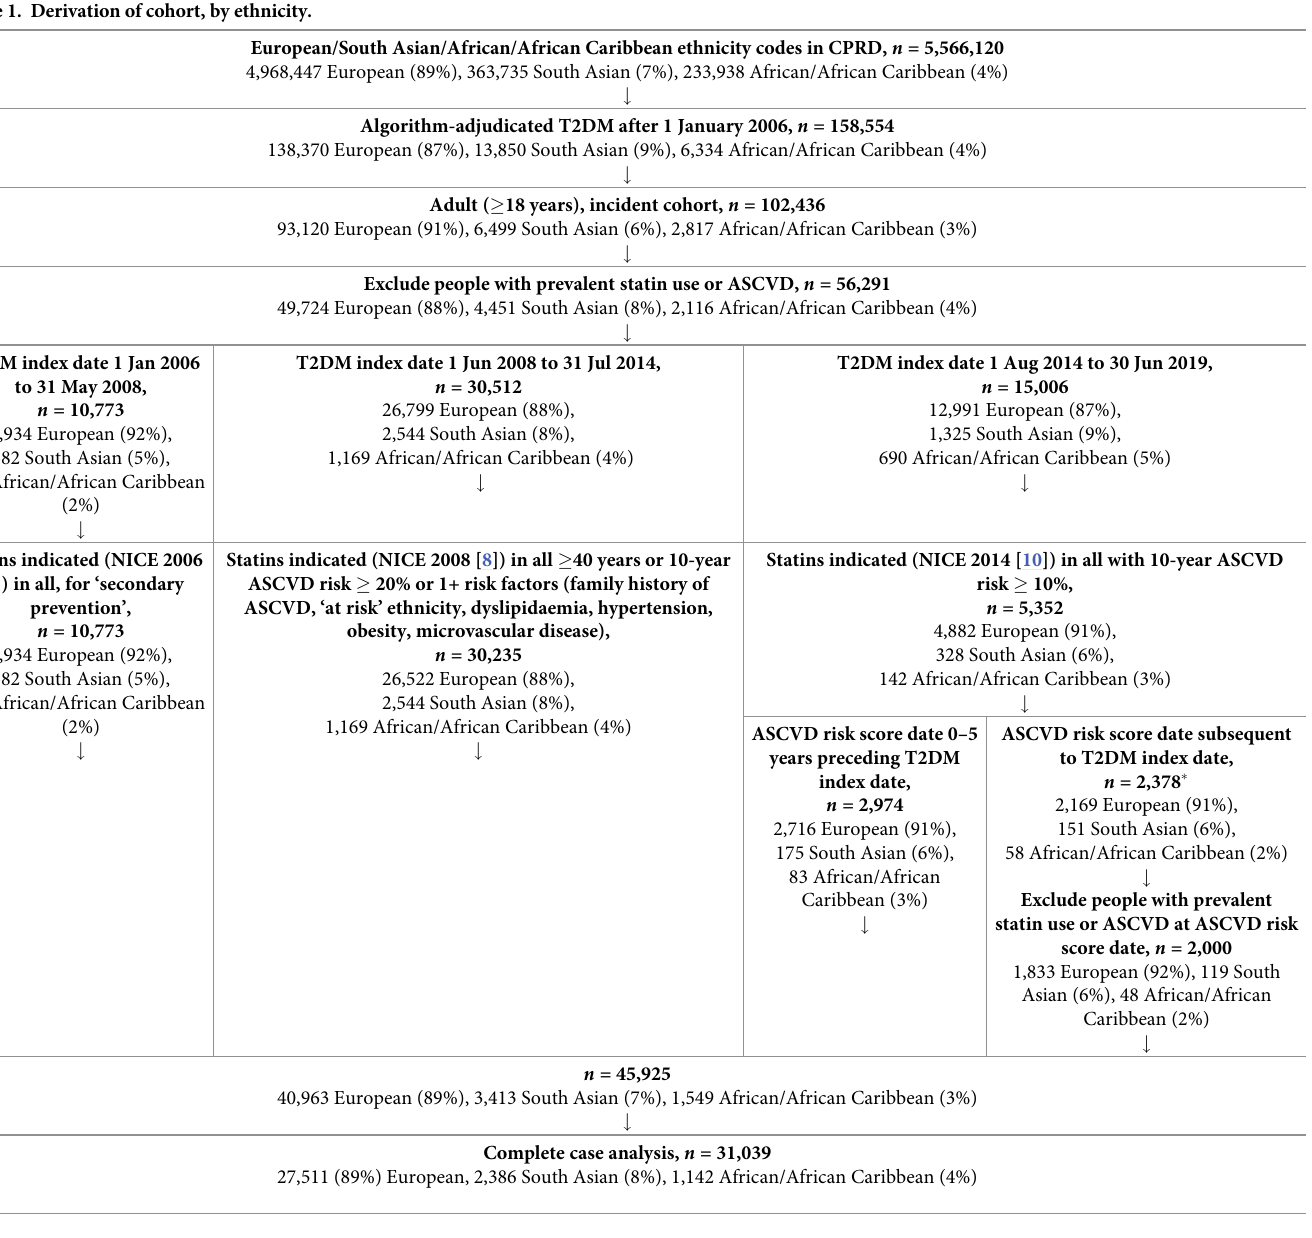
Table 1. Derivation of cohort, by